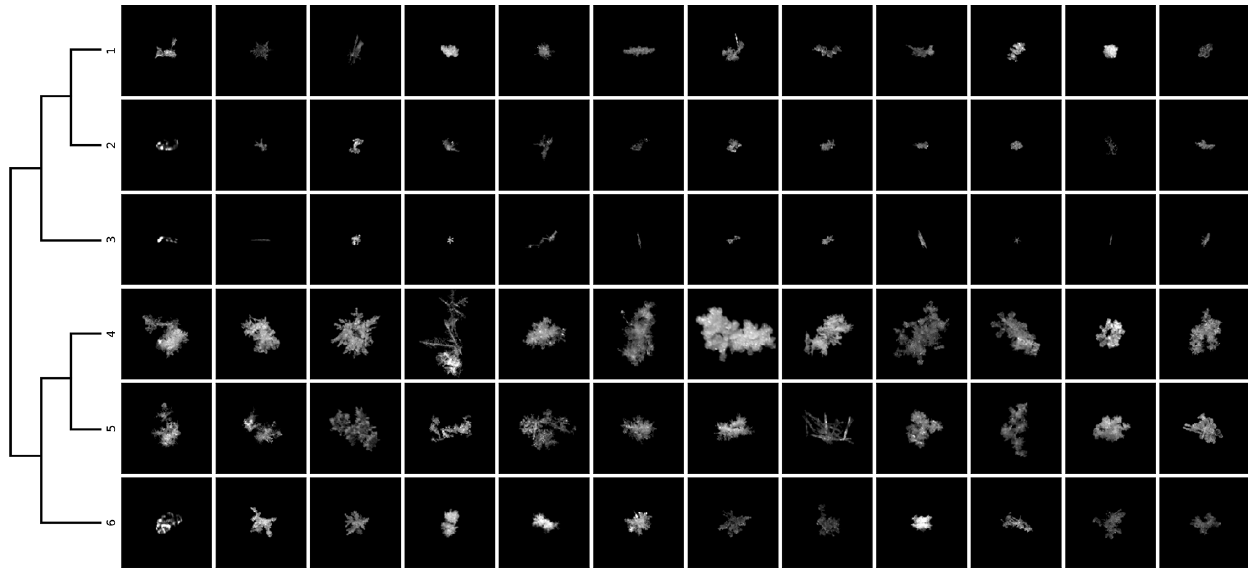
Figure 8. As in Fig. 5 but with K =